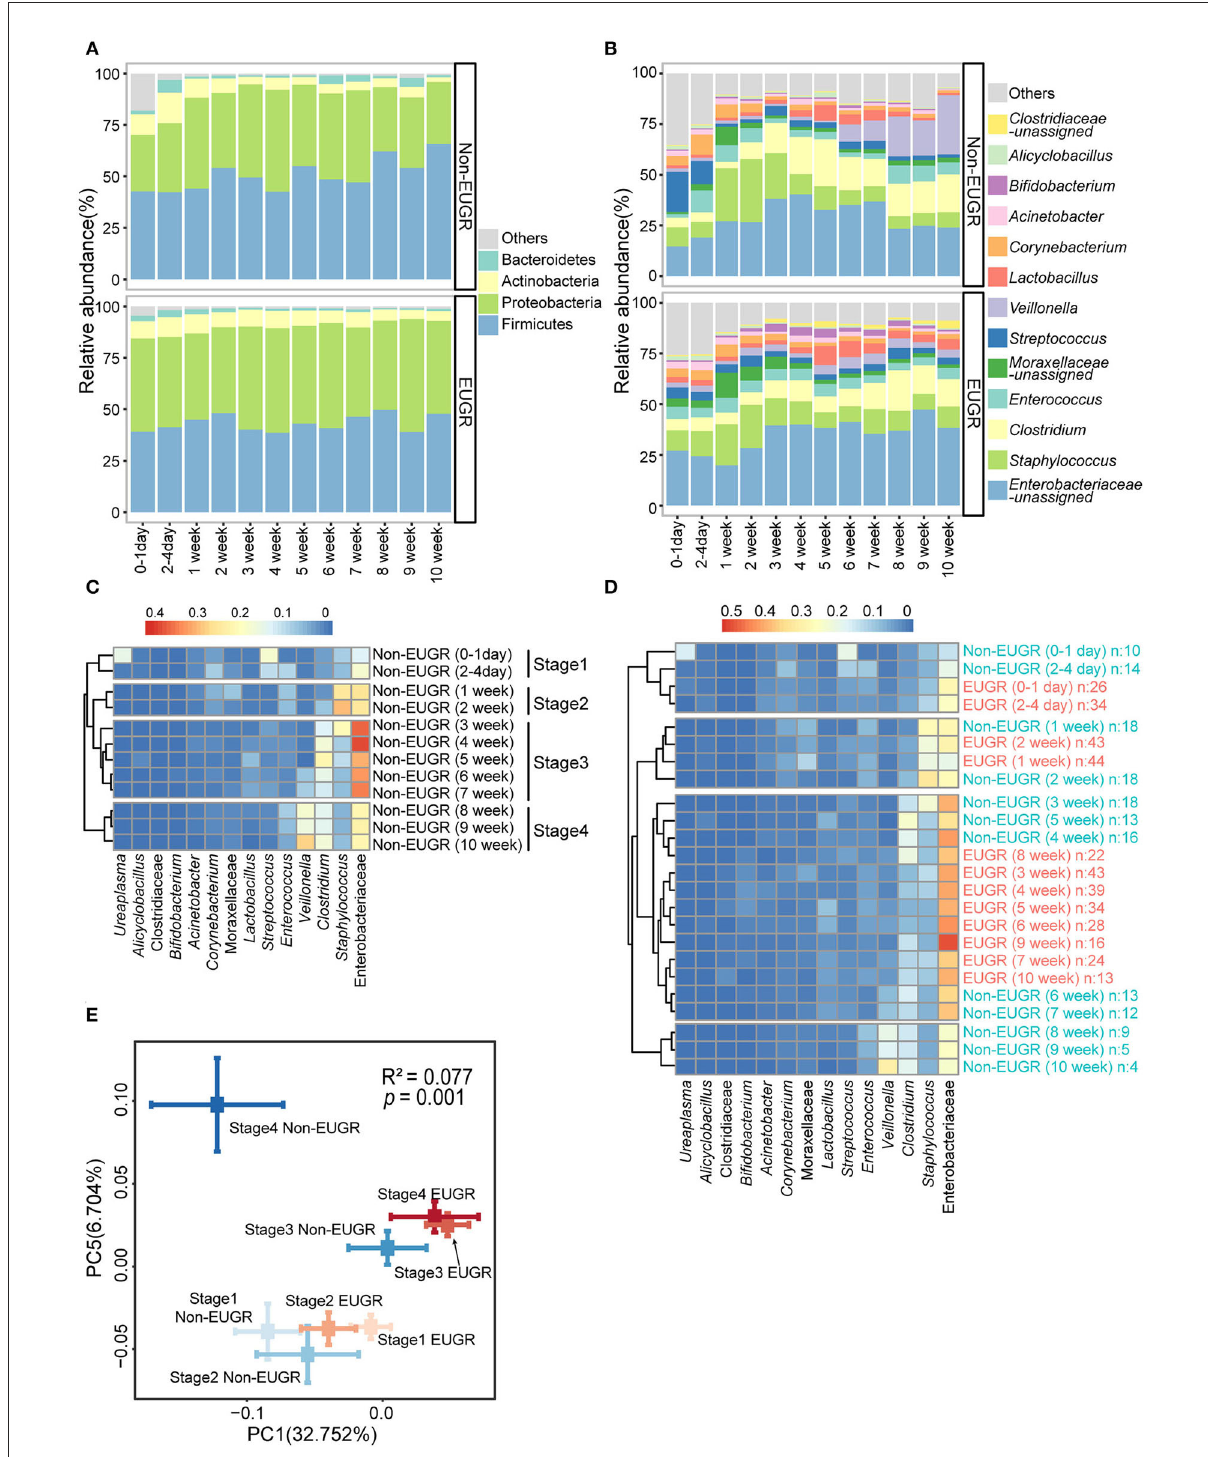
FIGURE1 The gut microbiota patterns of preterm birth infants with and without EUGR. (A,B) Average relative abundances of predominant taxa at the phylum and genus levels in the EUGR and non-EUGR groups. (C) Heatmap shows the predominant bacteria in the non-EUGR group clustered by time into four stages. (D) Heatmap shows the predominant bacteria in the EUGR group clustered together with the non-EUGR group. (E) Principal coordinate analysis based on unweighted UniFrac distances showing the mean values and standard errors of the PC axes of different groups (mean ± SE). Differences in beta diversity among groups were tested using permutational multivariate analysis of